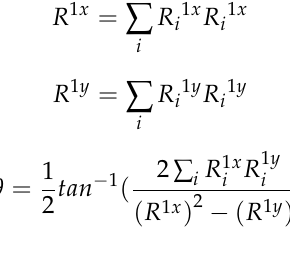
Figure 2. Representation using the circle of Mohr [22].